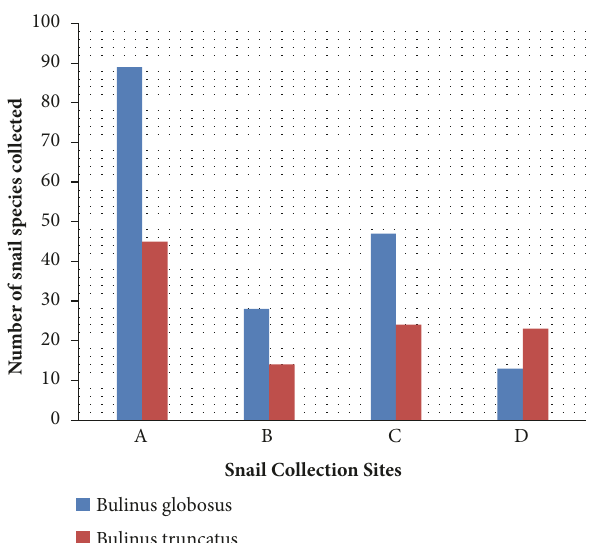
Figure 4: Distribution of different snail species in different sites